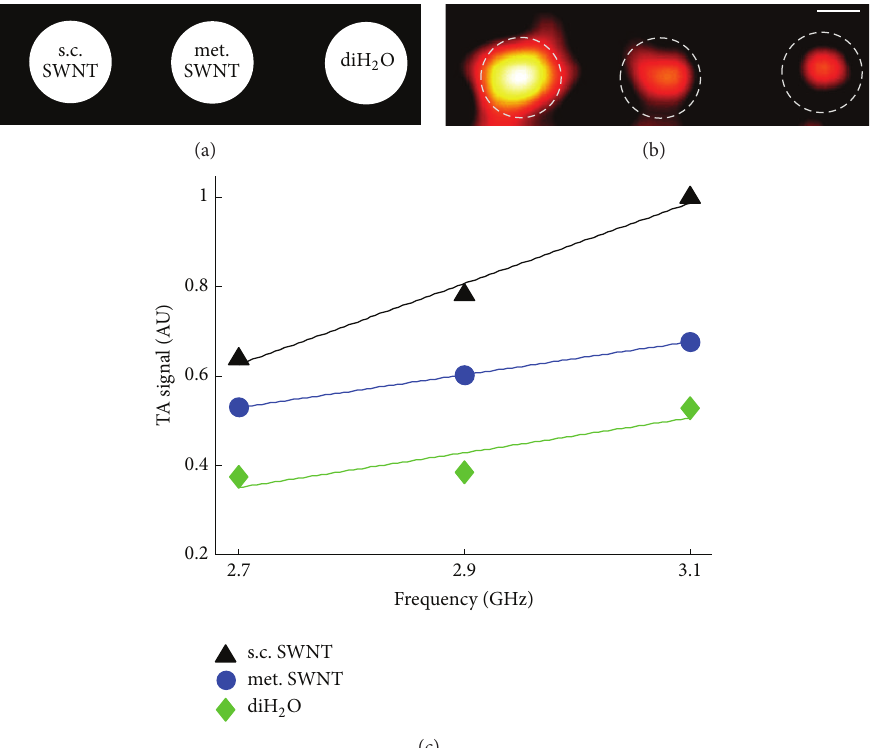
Figure 2: (a) Schematic cross-section of sample imaged in Figure 1(c) comprised of semiconducting SWNTs (s.c. SWNT, 300 ppm), metallic SWNTs (met. SWNT, 100ppm), and a baseline control of deionized water (diH 2 O). (b) TA image acquired with 3.1 GHz microwave radiation (8dB dynamic range). Tubes are outlined by gray circles. Scale bar = 2mm. (c) Average TA signal, over 4 × 4 mm 2 regions for semiconducting SWNTs ( 𝑚 = 2.32 AU/GHz, 𝑅 2 = 0.99 ) and metallic SWNTs ( 𝑚 = 0.95 AU/GHz, 𝑅 2 = 0.99 ) relative to the normalized slope of deionized water ( 𝑚 = 1.0 AU/GHz, 𝑅 2 = 0.80 ) as a function of incident microwave frequency.